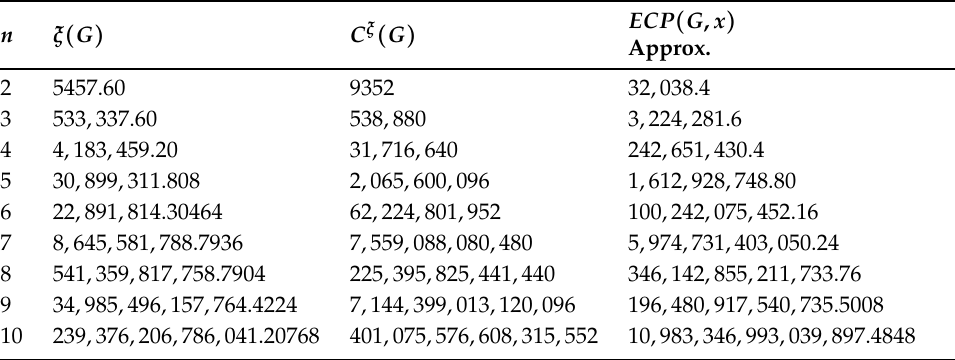
Table 3. Comparison of the ξ ( G ) , C ξ ( G ) and ECP ( G , x ) of G ∼ = CCC ( n )